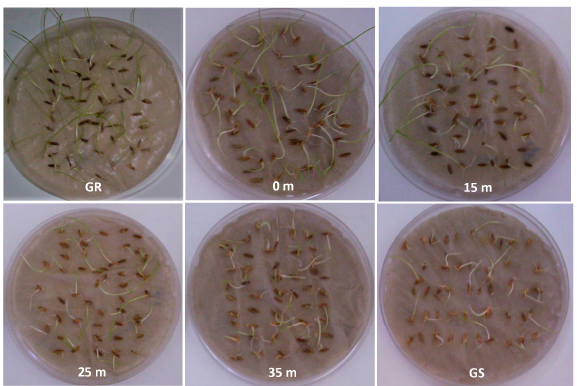
Figure 4. Progenies of pollen receptor plants (spaced from 0 to 35 m from the glyphosate-resistant plants as the source of pollen), glyphosate-resistant plants (GR, positive control), and isolated glyphosate-susceptible plants (GS, negative control) growing on a glyphosate solution (45 mg ae L − 1 ). The frequency distributions observed for plumule length for each sample were compared to the expected frequency (determined in the negative control), and the null hypothesis (H 0 ) was rejected in the cases of progenies obtained ≤ 25 m from glyphosate-resistant pollen donor plants (Table 1). The frequency distribution of plumule length on the progeny of the glyphosate-resistant plants differed significantly from those determined from the progeny of the negative control (Table 1). At least 40% of individuals from the positive control were found in the three upper classes (30–40 mm to 50–60 mm), while less than 2% of plumules from the negative control were included in these classes (Table 1, Figure 4).